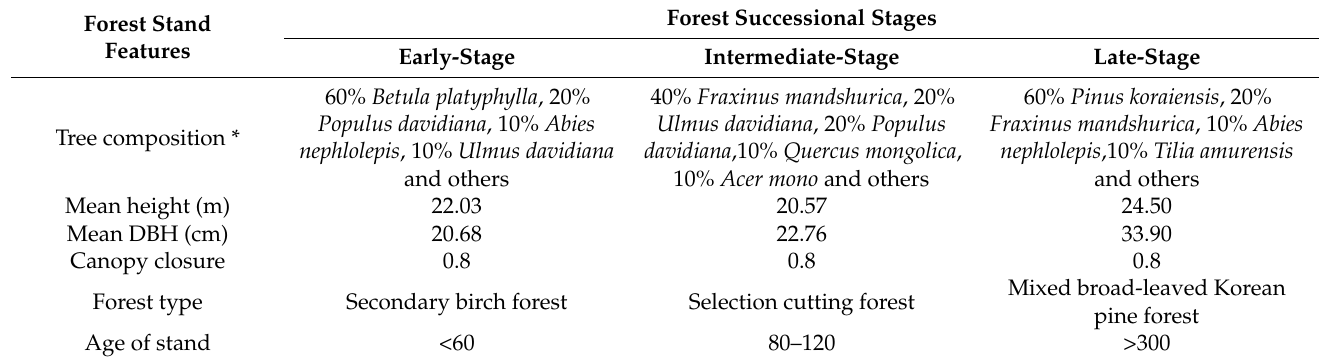
Table 1. Stand features of broad-leaved Korean pine forest at different successional stages in Lesser Hinggan